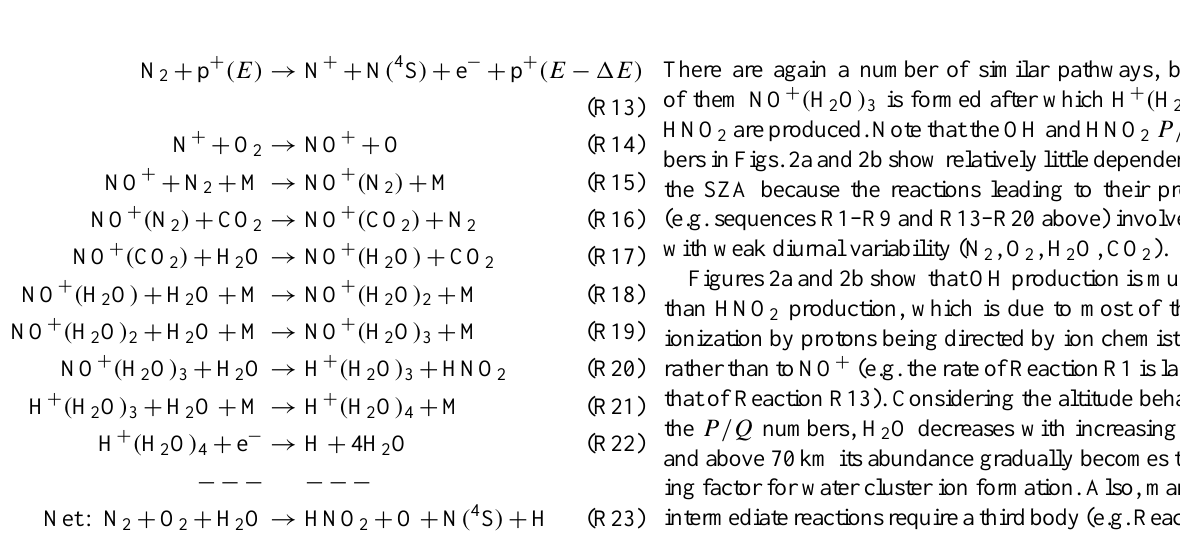
Fig. 2. P/Q numbers for January, Northern Hemisphere, and Q = 100cm − 3 s − 1 . Note that the colour scales of the panels